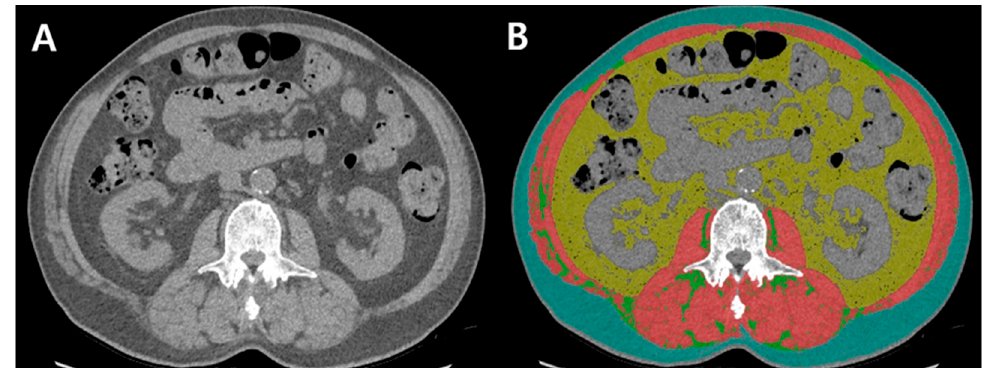
Figure 2. Cross-sectional CT images at the level of L2. ( A ) Unenhanced chest CT, ( B ) using AutoMATiCA software, body composition variables are grouped into the distinct colored area (skeletal muscle area, red; visceral adipose tissue area, yellow; subcutaneous adipose tissue area, blue; intermuscular adipose tissue, green).